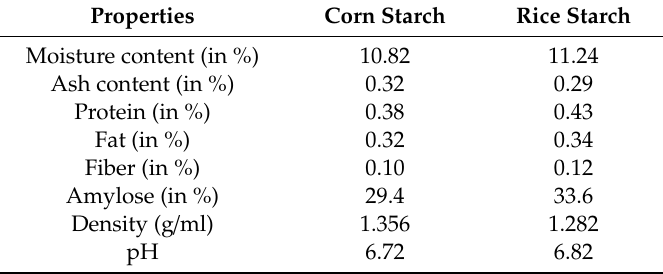
Table 3. Composition of prepared bioplastics.